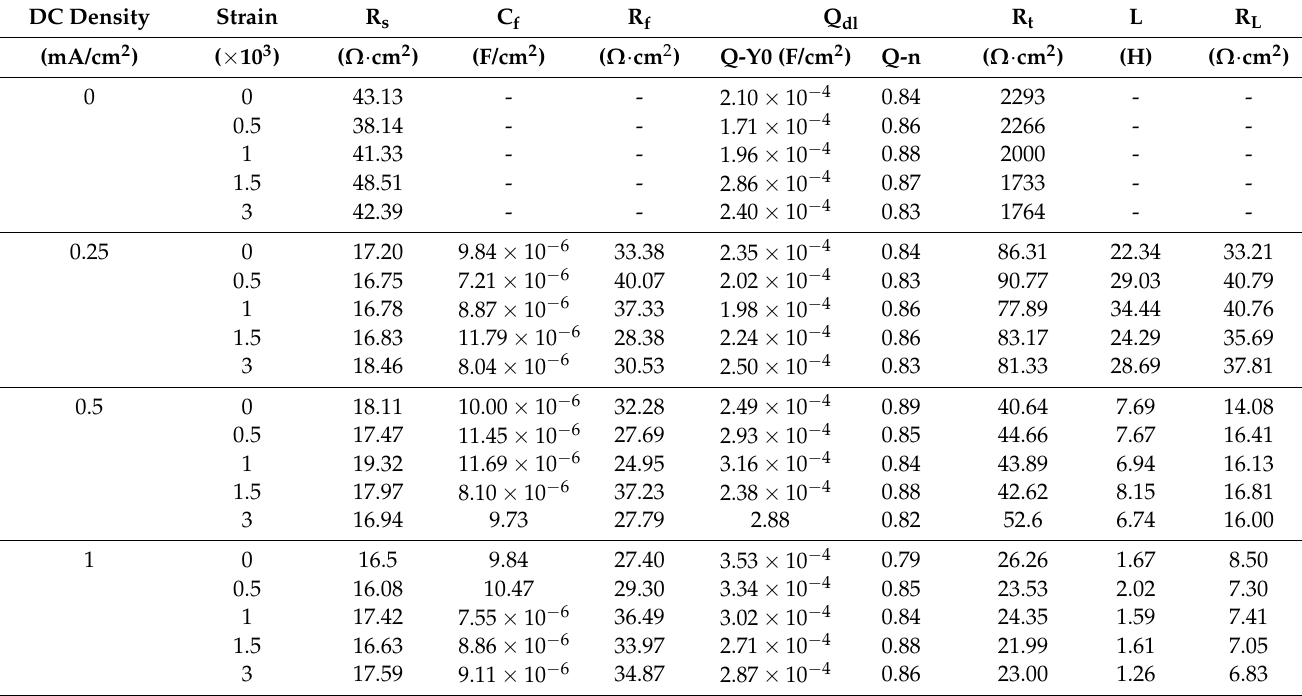
Table 3. Fitted EIS parameters of X80 steel samples after applying various DC densities and strains.